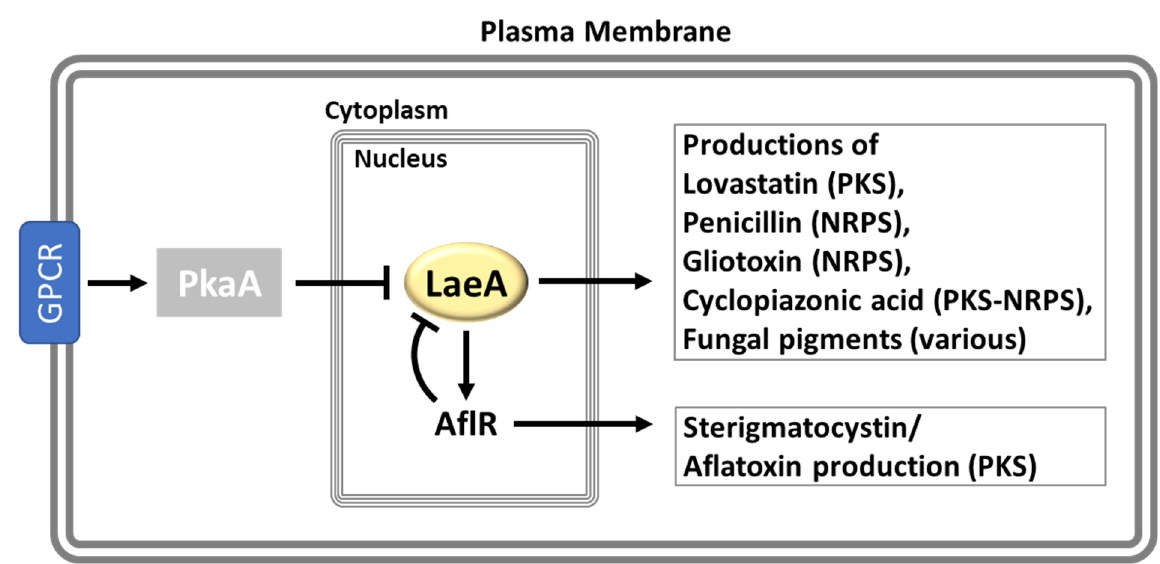
Figure 6. The functions of LaeA in Aspergillus . See the “LaeA, a Global Regulator of Secondary Metabolism” section.